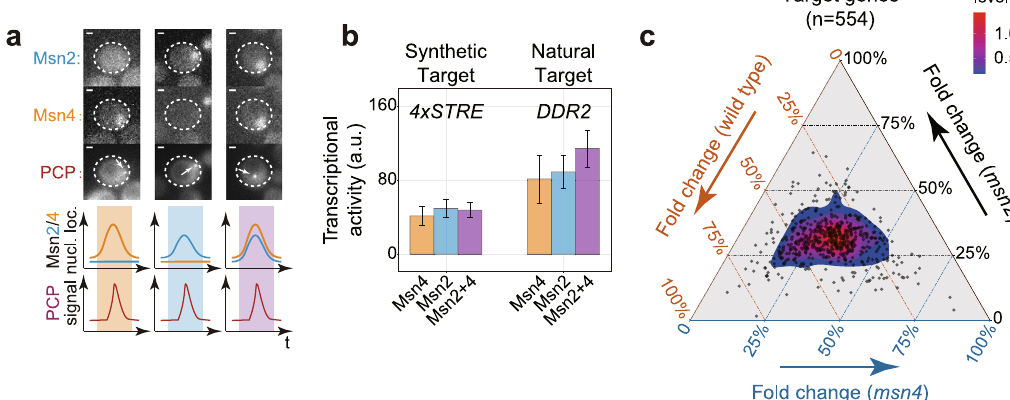
Fig. 2 Individual pulses of Msn2 and Msn4 display functional redundancy. a Example snapshots (top, out of 148, 227, and 262 events, respectively) and schematics (bottom) illustrating three types of TF nuclear localization dynamics (left to right: Msn4-only, Msn2-only, and coincident pulse) and target gene responses (i.e., nascent transcription sites indicated by white arrows). Scale bars indicate 1 μ m. b Pulse-triggered averaging analysis 14 of the transcriptional activities of PP7-based synthetic reporter gene ( 4xSTRE ) and endogenous target gene ( DDR2 ) in response to three types of TF dynamics under glucose limitation stress (0.1% glucose). Event numbers are 148, 227, 262, 122, 247, and 260. Error bars indicate 95% CIs and centers indicate means. See also Supplementary Fig. 14a. c Genome-wide characterization of functional redundancy between Msn2 and Msn4 pulses by RNA-seq. Synchronized Msn4-only pulse, Msn2-only pulse, and Msn2/Msn4 co-pulse across cell population as in ( a ) were achieved by inducing cells of three different genotypes ( msn2 , msn4 , and wild type) by 0.5 M KCl. For each target gene, expression fold change between stress versus non-stress conditions was calculated for each genotype and shown in the ternary plot after normalization. Colormap represents gene